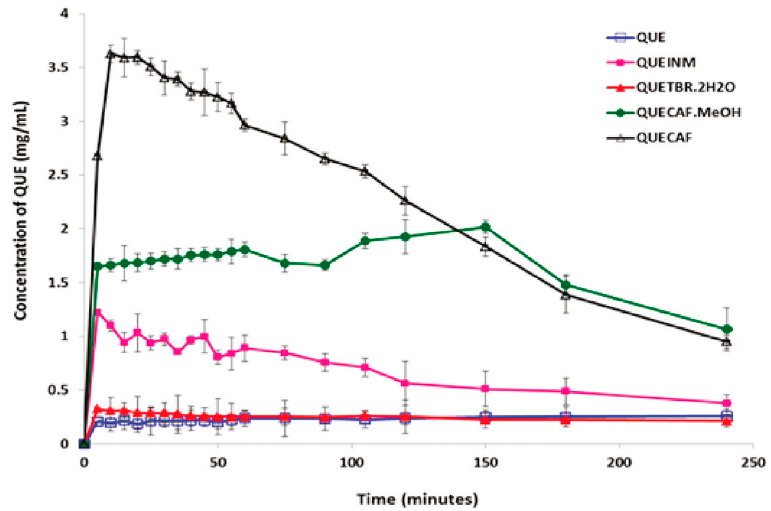
Figure 48. Dissolution profile of quercetin dihydrate and its cocrystals in 1:1 ethanol/water mixture after the first 4 h. Adapted with permission from Mol. Pharmaceutics , 2011, 8 (5), 1867–1876. Copyright 2011, American Chemical Society.